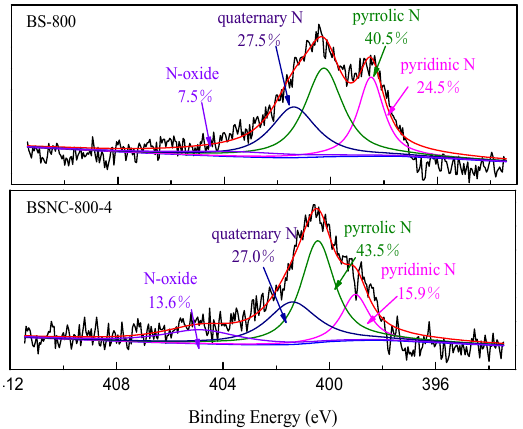
Figure 3. XPS spectra of N1s for BS-800 and BSNC-800-4.